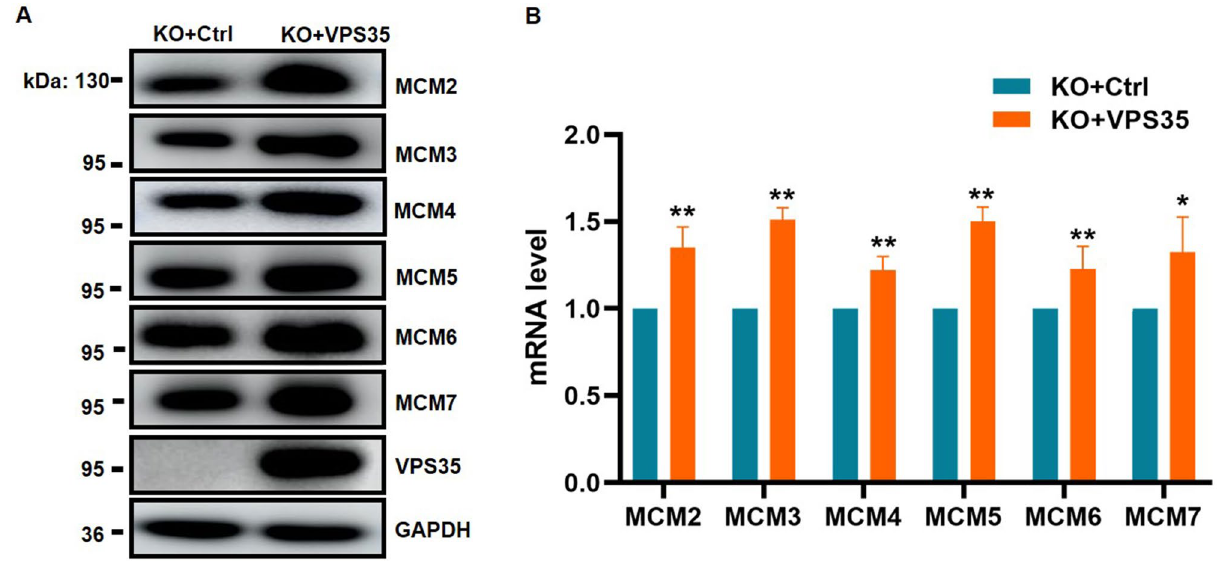
Figure 5. VPS35 rescued VPS35 KO cells restore the expression of MCM2-7 genes. VPS35 KO HeLa cells were infected with pLenti6.3-Flag.VPS35 or pLenti6.3-Flag.vector control lentivirus and selected with blasticidin. The protein ( A ) and mRNA ( B ) levels of MCM genes were examined in these stable cell lines by western blotting and qRT–PCR analysis, respectively. *, p < 0.05 vs. KO + Ctrl; **, p < 0.01 vs. KO + (Fig. 4B), which was consistent with the protein expression in VPS35 KO cells (Fig. 3C and D). These results sug- gested that VPS35 was involved in the mRNA expression of MCM2-7.